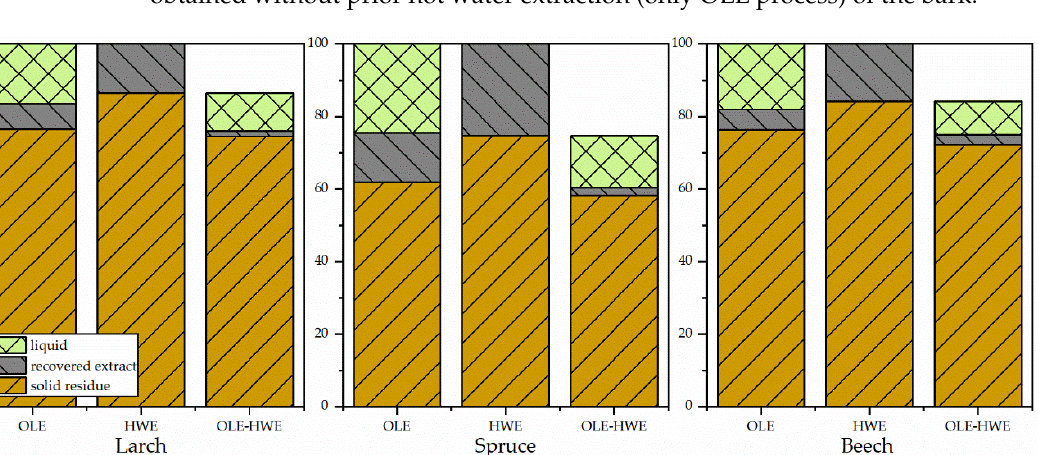
Figure 2. Extraction yield in recovered and liquid form, solid